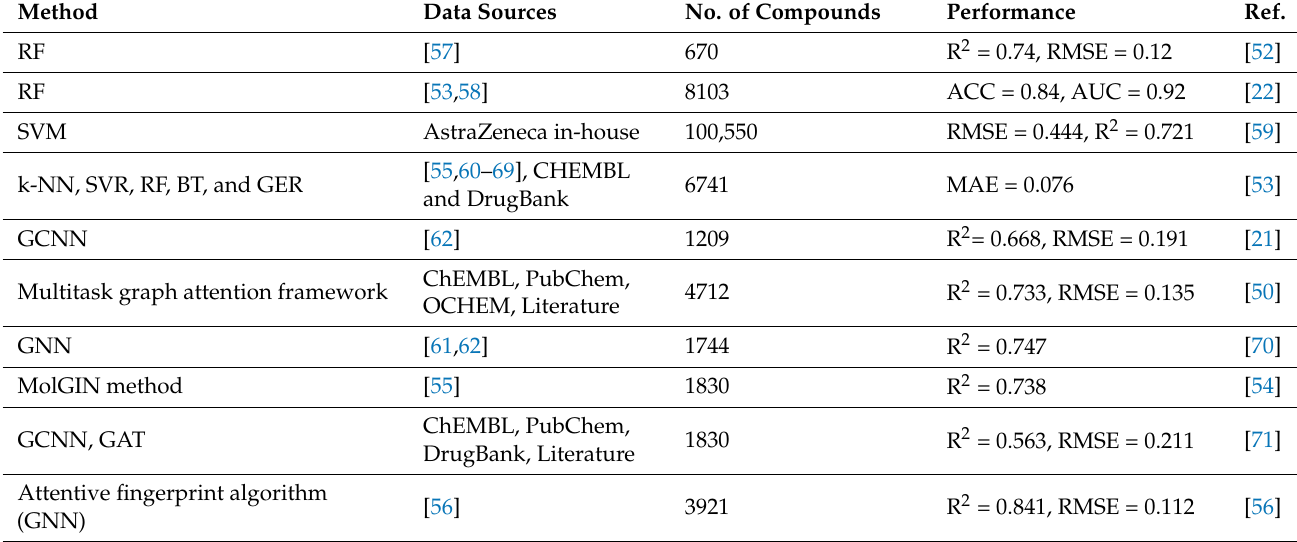
Table 2. Summary of recent AI-based studies predicting PPB